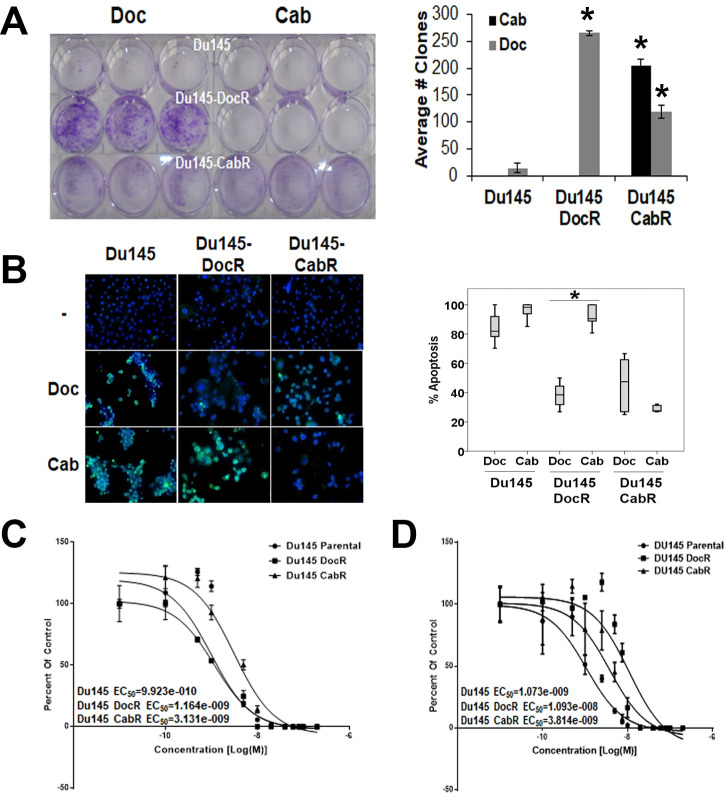
In vitro validation of the resistance against taxanes in Du145 cells.(A) Left panel: representative pictures showing the formation of clones by Du145 age-matched, DocR and CabR cells under 50nM Doc or Cab. Right panel: Quantification of clone formation counted 30 days after ending the treatment. Error bars: mean ± SD from triplicates. *: P < 0.05 showing statistical significance. (B) Left panel: Representative pictures of apoptosis in Du145 age matched, DocR and CabR resistant cells using TUNEL assay. Cuts in DNA (Green) and nucleus staining with DAPI (Blue) are shown. Right panel: quantification of apoptosis (Boxplot graphs showing the median, inter-quartile range, upper and lower quartiles, and whiskers) measured from more than 300 cells per condition treatment. The experiment was repeated three times. Statistical analysis was performed using one-way ANOVA on Ranks, Kruskal-Wallis Analysis, followed by Dunn’s post-hoc test. *P<0.05). (C-D) Growth curves of age-matched, DocR and CabR cells under increasing concentration of Doc (C) or Cab (D). After 24 hours treatment, cells were fixed, stained using crystal violet solution, rinsed and air dried. Alive cells [cells that do not present cell death signs within the nucleus (chromatin condensation and chromosomal DNA fragmentation visualized by DAPI staining)] were then counted in each well. Each treatment condition was tested in triplicate; each experiment repeated at least three times. Quantification was done from three different experiments and data are expressed as mean ± SD.